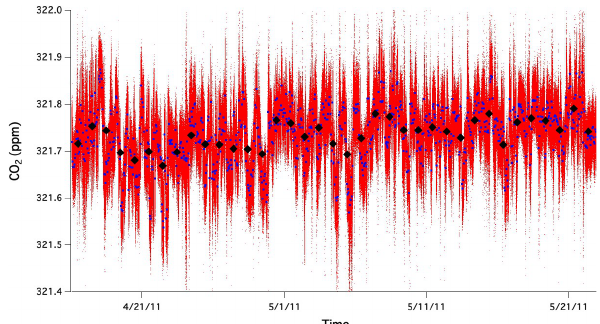
Fig. 7. One month continuous monitor of the CO 2 mixing ratio from a second sealed quartz cell without any calibration or operational intervention. The overall temperature change during the measure- ment month was ∼ 20K. Sample rate is 1Hz. Real-time data are shown in red without any averaging. The blue dots and the black diamonds are calculated hourly and daily averaged values. They show essentially no CO 2 drift within one-month period and less than 0.1ppm day-to-day CO 2 variations. The one-sigma standard deviation is 0.059ppm for the hourly mean and is 0.031ppm for the daily